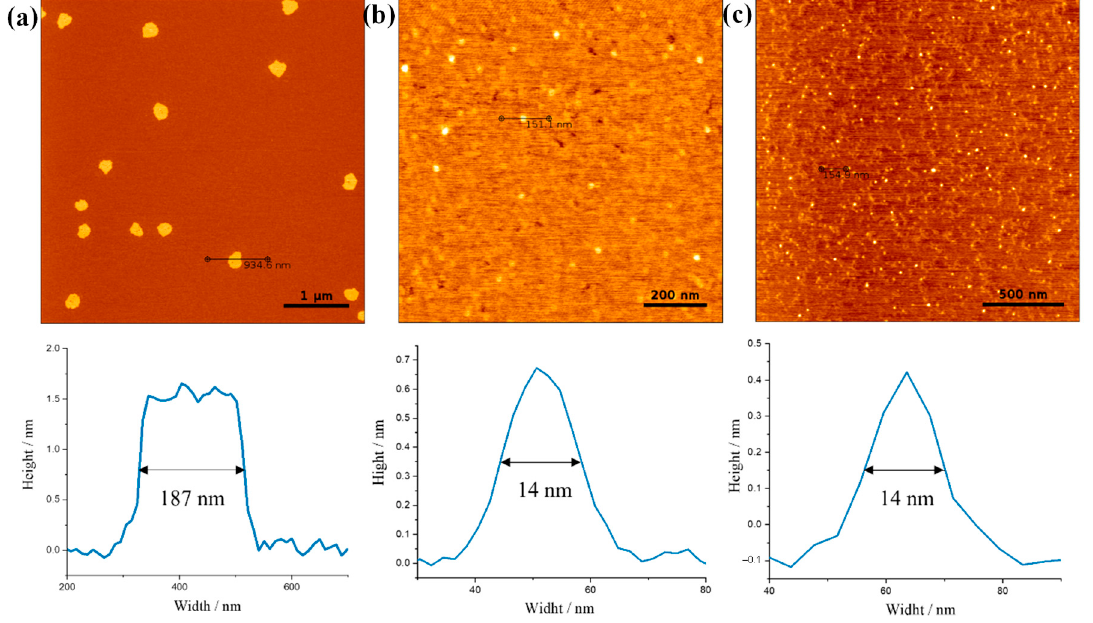
Figure 3. Atomic force microscopy (AFM) images and cross-section analysis of the M-GNS dispersed in a mixture of ethanol:water:EG = 0.50:0.45:0.05. The sample was spin-coated on freshly